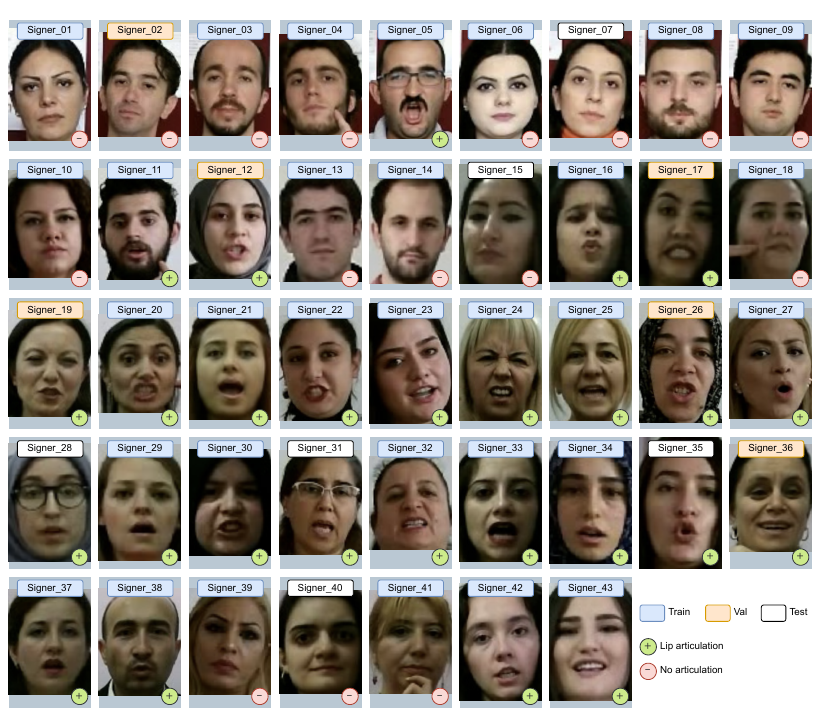
Figure 1. Examples of signers’ faces from the AUTSL